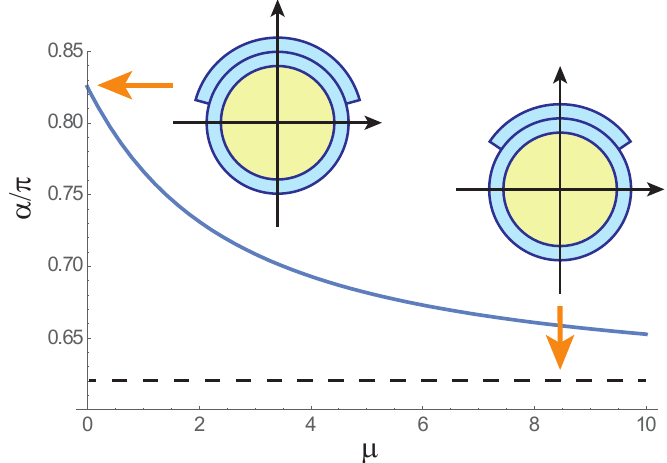
Figure 3. Optimal patch width of thin pneumatic actuator as function of pressure-dependent structural parameter µ = ( P / E )( R / t ) . The thicknesses of the patch and the tube are alike. Insets show optimal actuator cross-sections for µ = 0 and µ (cid:29)